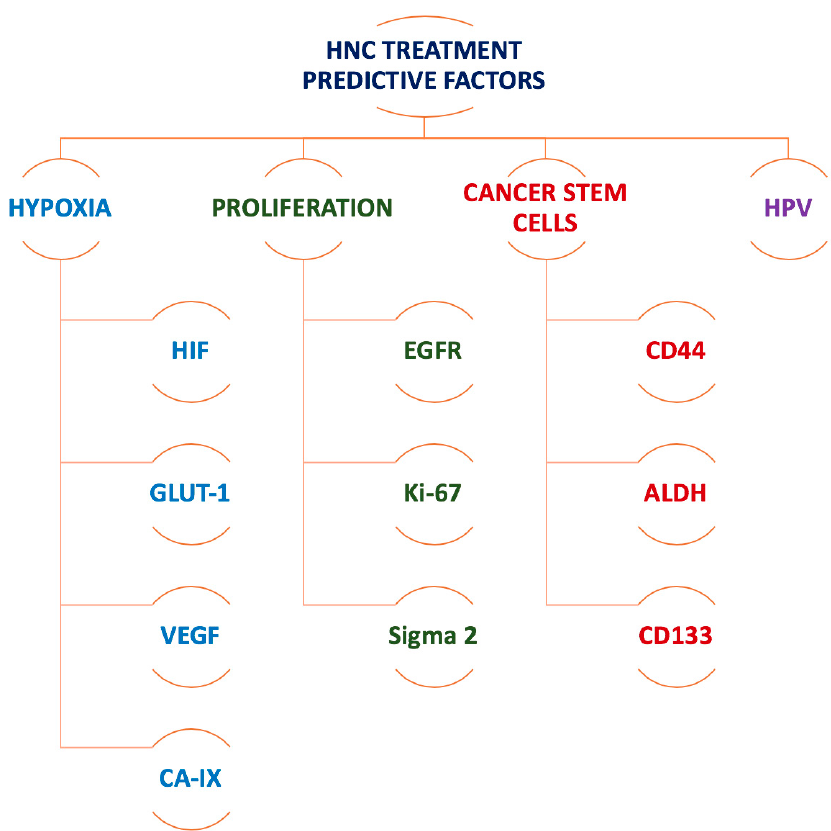
Figure 1. Summary of the most commonly investigated biomarkers that affect head and neck cancer (HNC) response to treatment. HPV, human papilloma virus; HIF, hypoxia inducible factor; GLUT-1, glucose transporter 1; VEGF, vascular endothelial growth factor; CA-IX, carbonic anhydrase IX; EGFR, epithelial growth factor receptor; Ki-67, cell proliferation-associated nuclear antigen; CD, cluster of differentiation molecule; ALDH, aldehyde dehydrogenase.